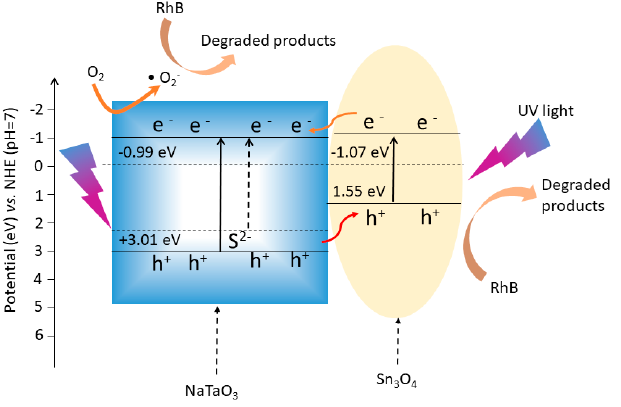
Figure 5. Photocatalytic degradation activities ( a ) and plots ( b ) of –Ln (C t /C 0 ) vs. irradiation time for RhB degradation under ultraviolet light irradiation, measured at regular time intervals in the presence of NaTaO 3 , NTO-S, Sn/NTO, Sn/NTO-S, and Sn 3 O 4,